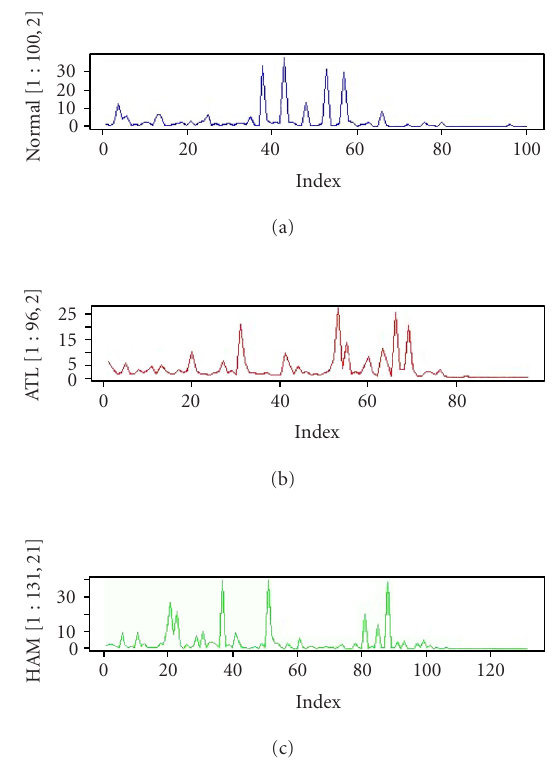
Figure 1. Three cut expressions from a normal, an HAM, and an ATL patient.